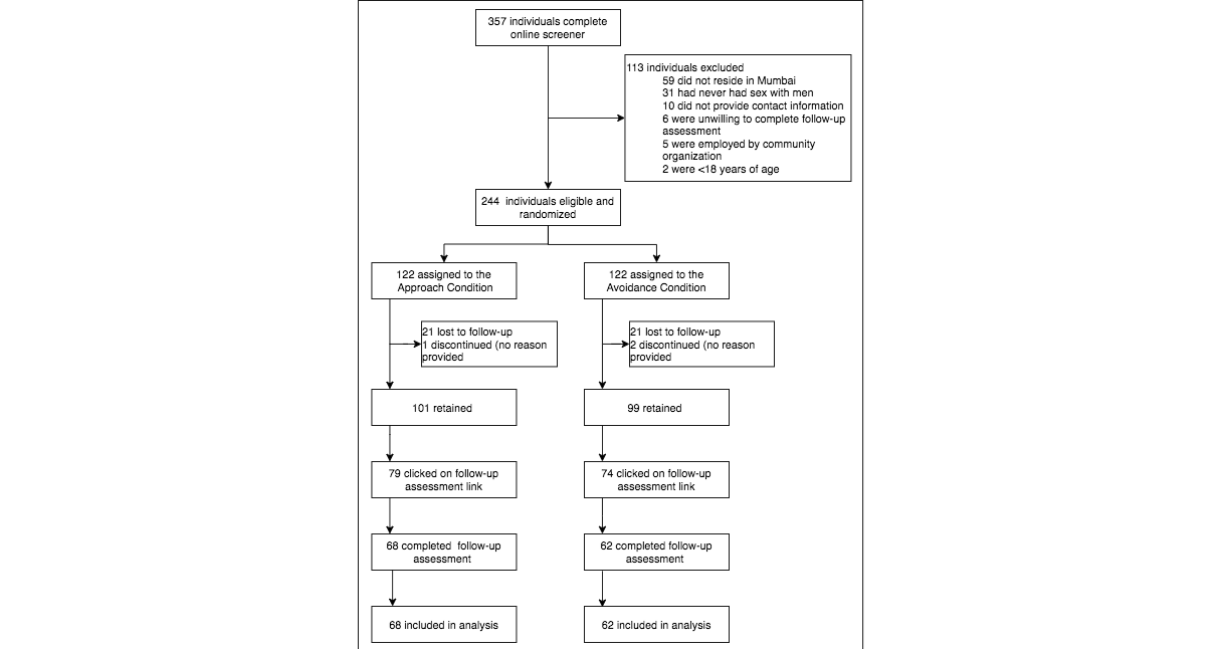
Figure 1. Consolidated Standards of Reporting Trials (CONSORT) flow diagram of CHALO!